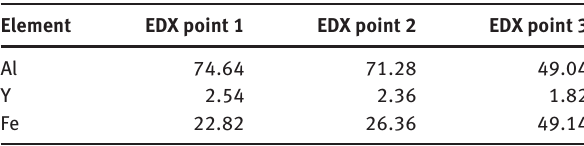
Table 1: Content of main constituents at various points in Figure 1B